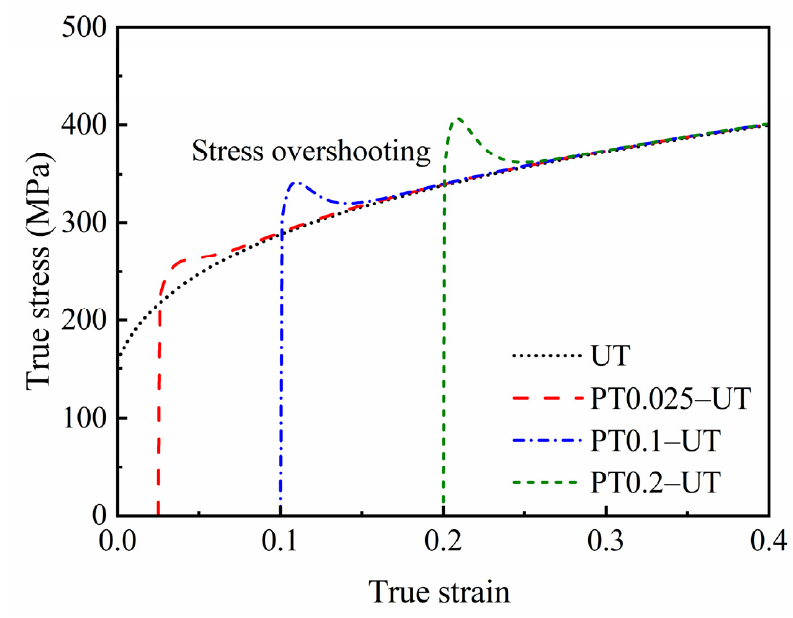
Figure 9. Stress–strain curves predicted by the HAH-2d model in plane strain tension–uniaxial tension with different pre-strain levels.